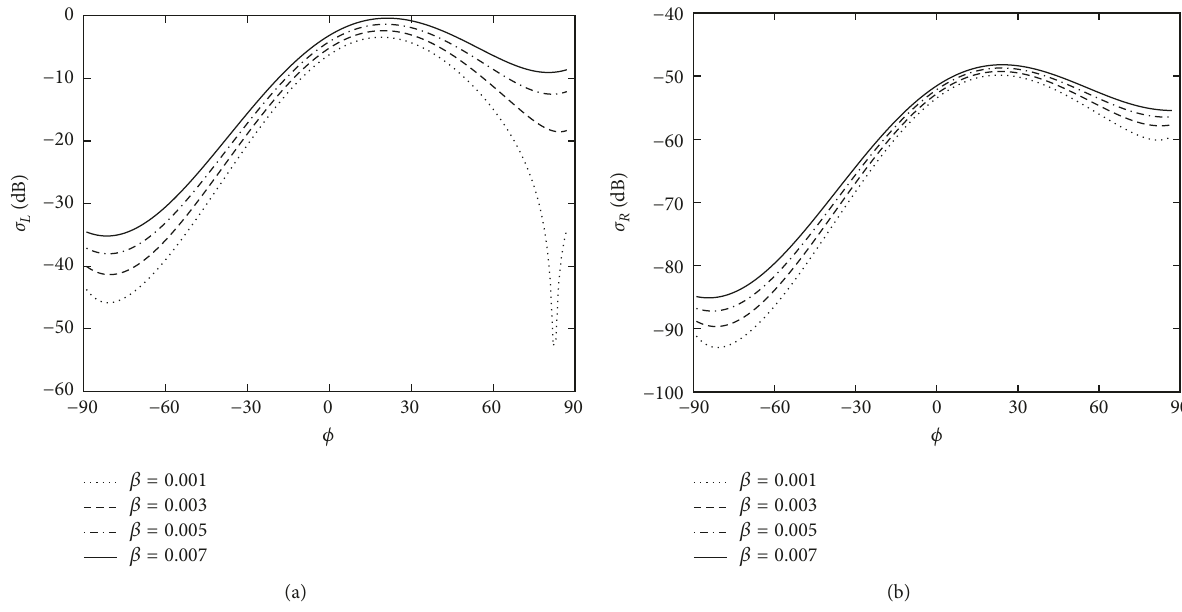
Figure 2: LCP and RCP scattering coefficients for different values of chirality, where φ